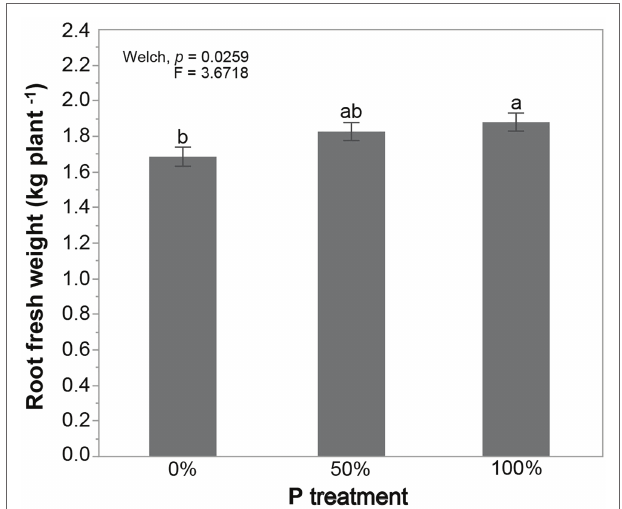
FIGURE 1 | Effects of phosphorus (P) fertilization on cassava root fresh weight averaged over the three locations, all cassava varieties, and all arbuscular mycorrhizal fungi (AMF) treatments. Error bars represent ±SE. Means with different letters are significantly different at p < 0.05 according to a Games-Howell post hoc